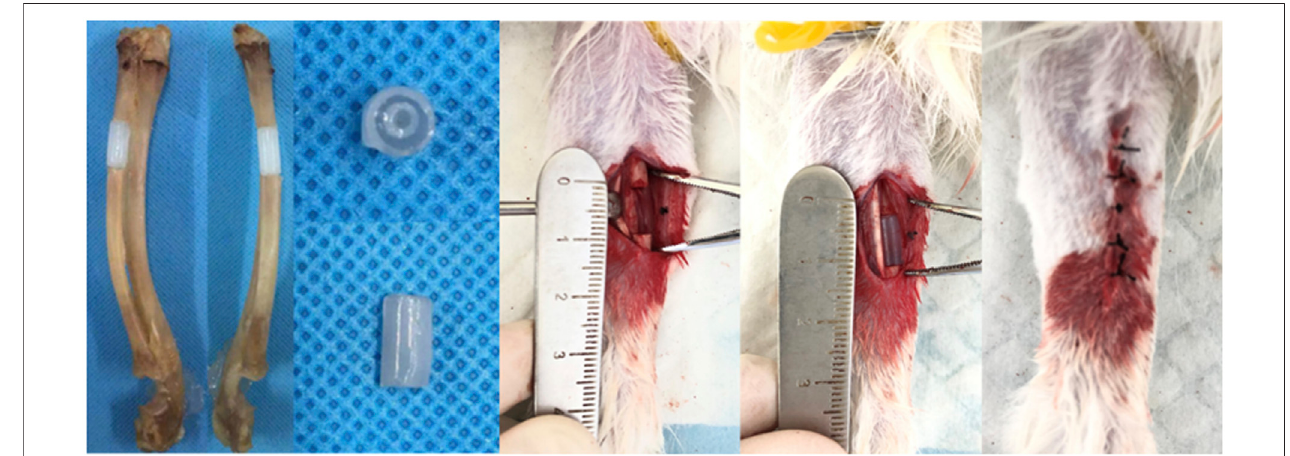
FIGURE 10 | Preparation of the rabbit radius critical-size bone defect model and scaffold implantation.